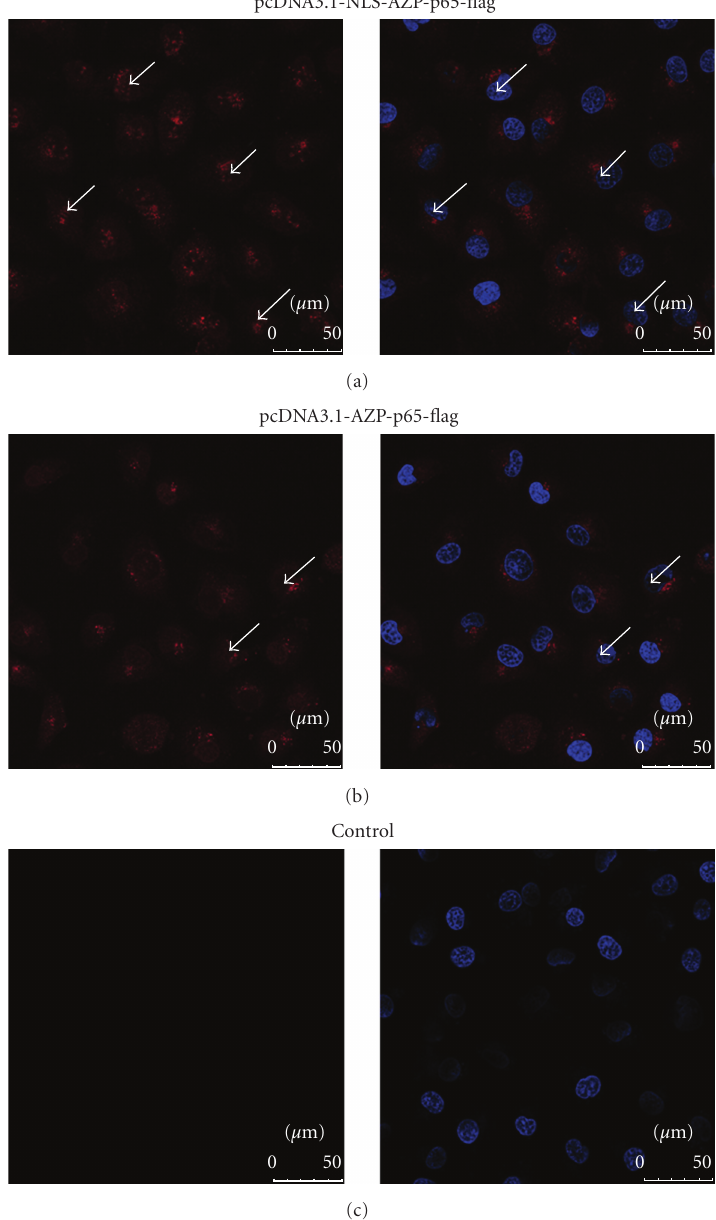
Figure 4: Expression of the ATF in the ECV304 cells. Immunofluorescence was performed, and the resulting cells were observed under a laser scanning confocal microscope. (a) ECV304 cells transfected with pcDNA3.1-NLS-AZP-p65-flag. (b) ECV304 cells transfected with pcDNA3.1-AZP-p65-flag. (c) ECV304 cells transfected with the control plasmids. The white arrows pointed the expressed proteins which were located in the